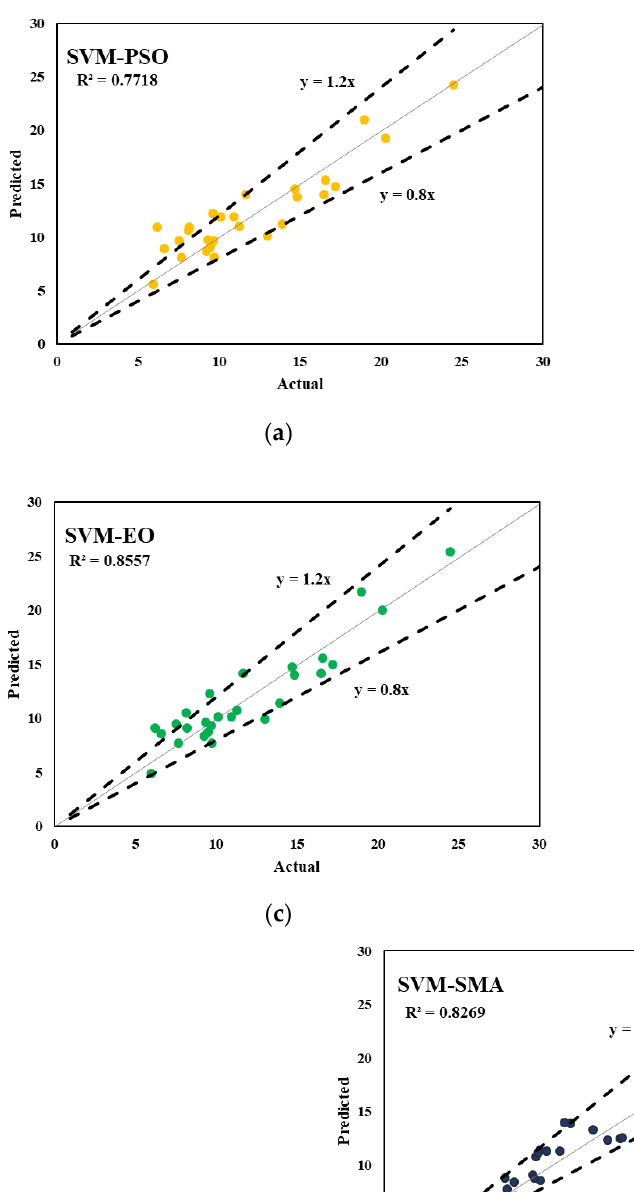
Table 7. Performance indices for the testing dataset. Indices